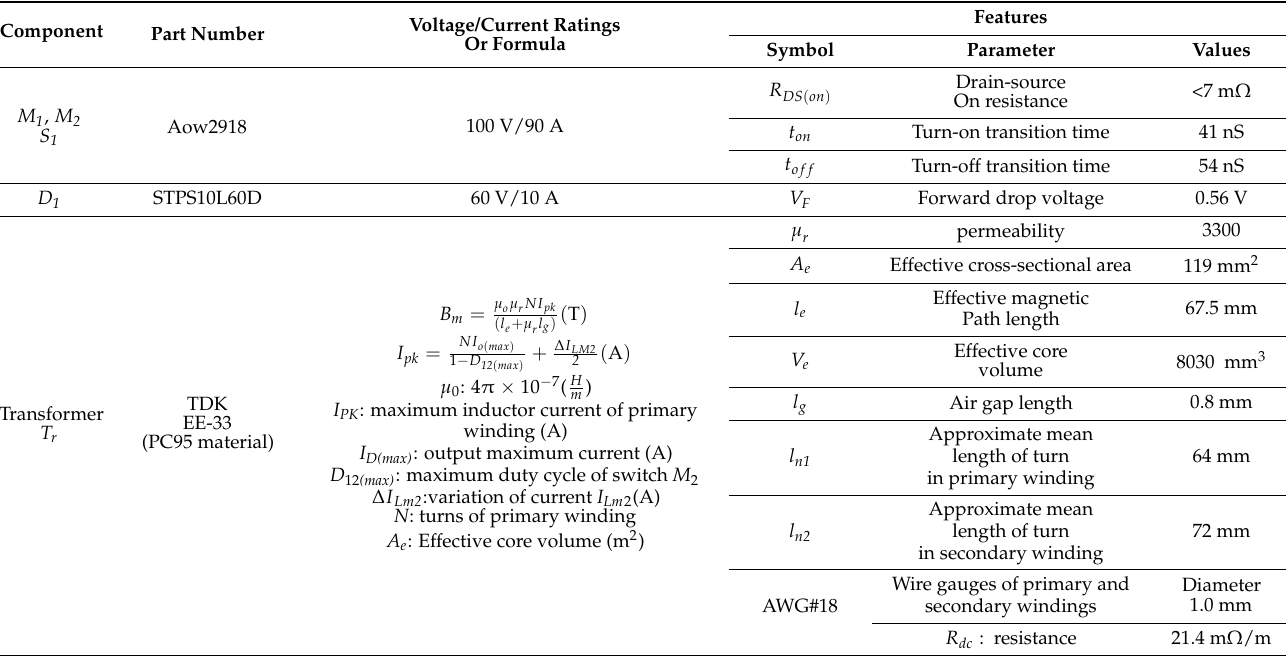
Figure 22. Comparison conversion efficiency between the conventional hard-switching flyback converter and the proposed one from light load to heavy load for operating in the discharging mode. Table 7. Key component parameters of the proposed hybrid